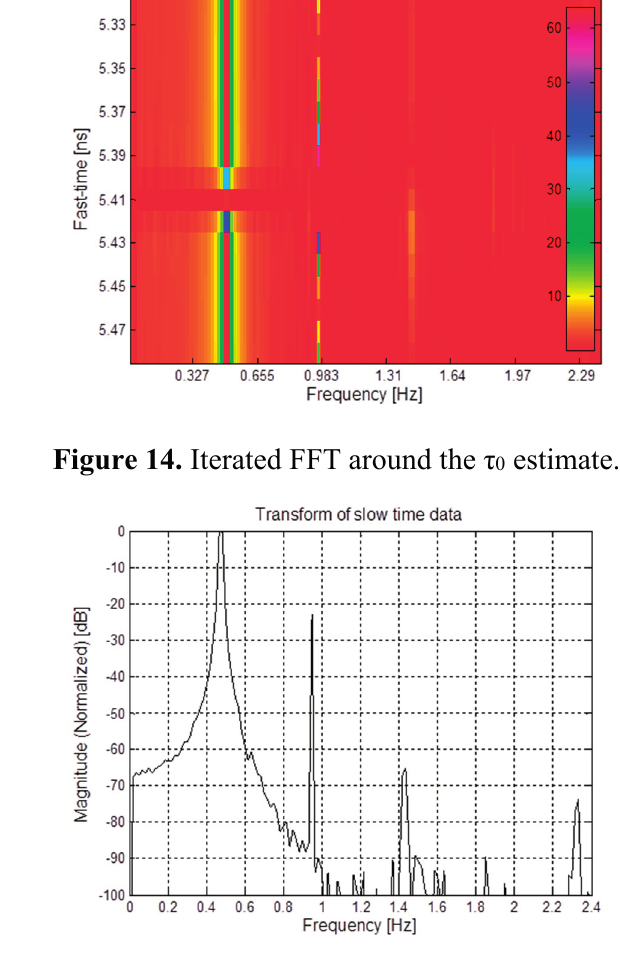
Figure 15. Average FFT for the considered